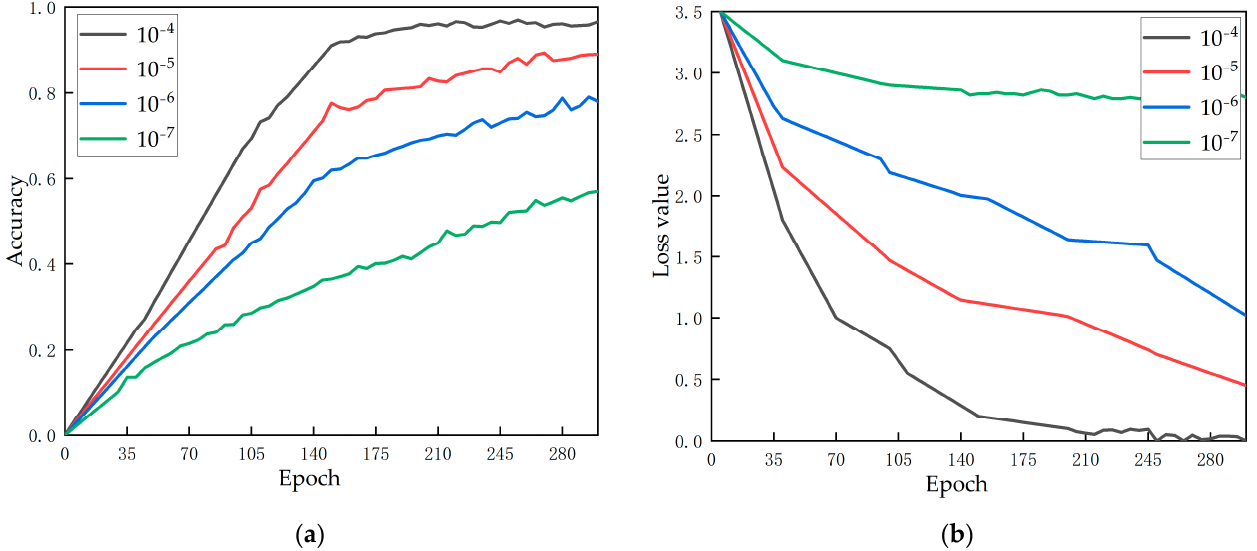
Figure 7. ( a ) Effect of the learning rate on accuracy; ( b ) Effect of the learning rate on loss.